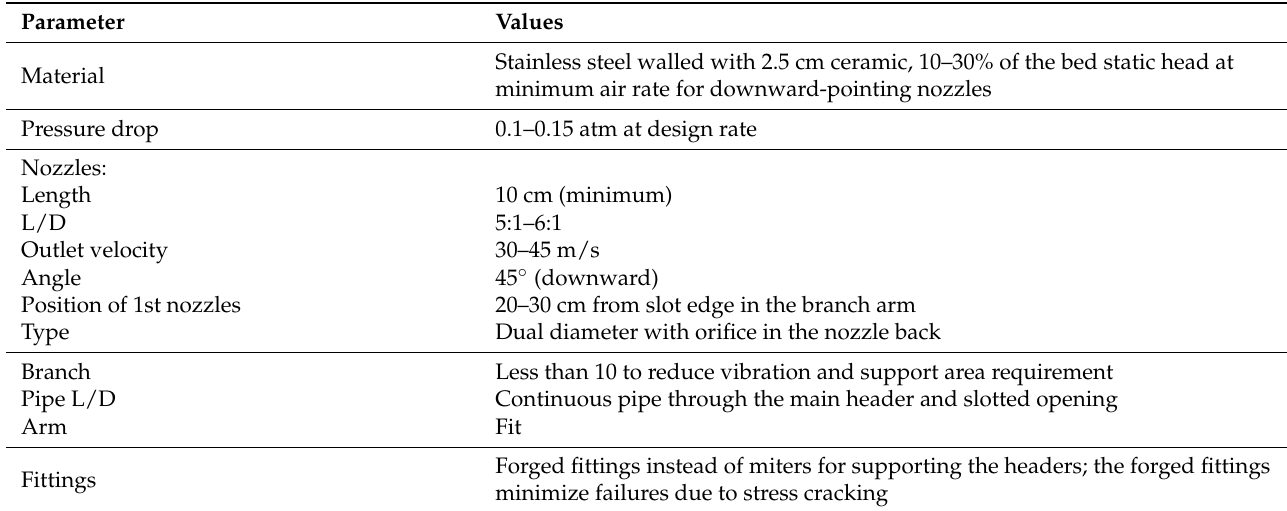
Table 5. Process and design consideration for pipe grid air